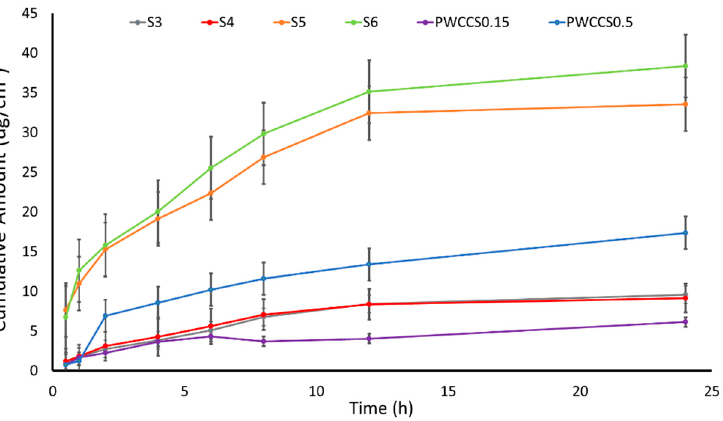
Figure 2. The anthocyanin permeation profiles for PWCCS0.15, PWCCS0.5, and the sericin hydrogels S3–S6 through the porcine skin in PBS pH 5.5 ( n = 3).